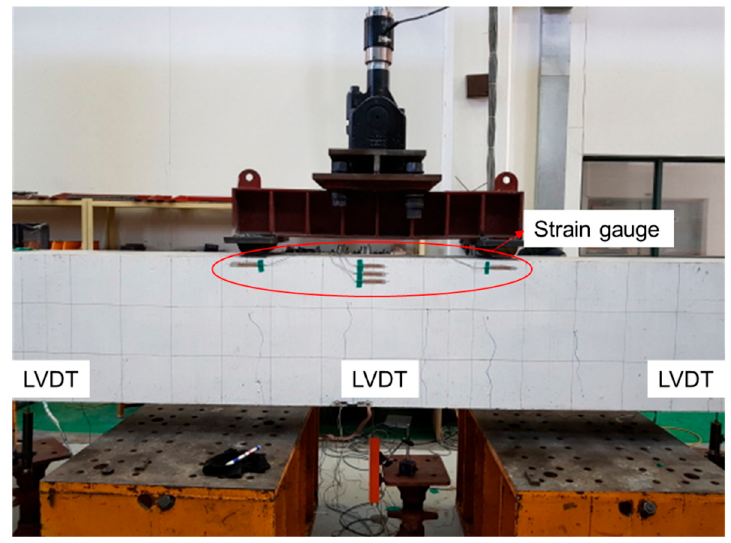
Figure 3. Sensor Figure 3. Sensor setup.